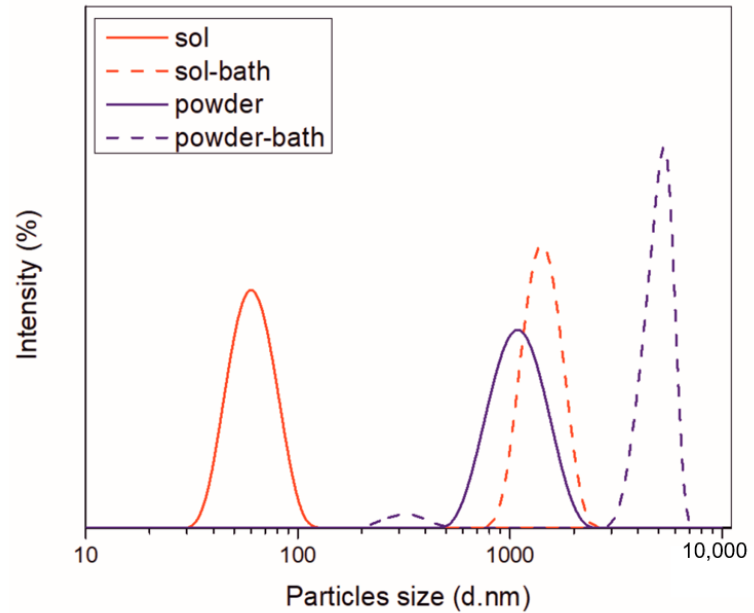
Figure 3. PSD of ceria sol and ceria powder before and after incorporation in deposition bath.